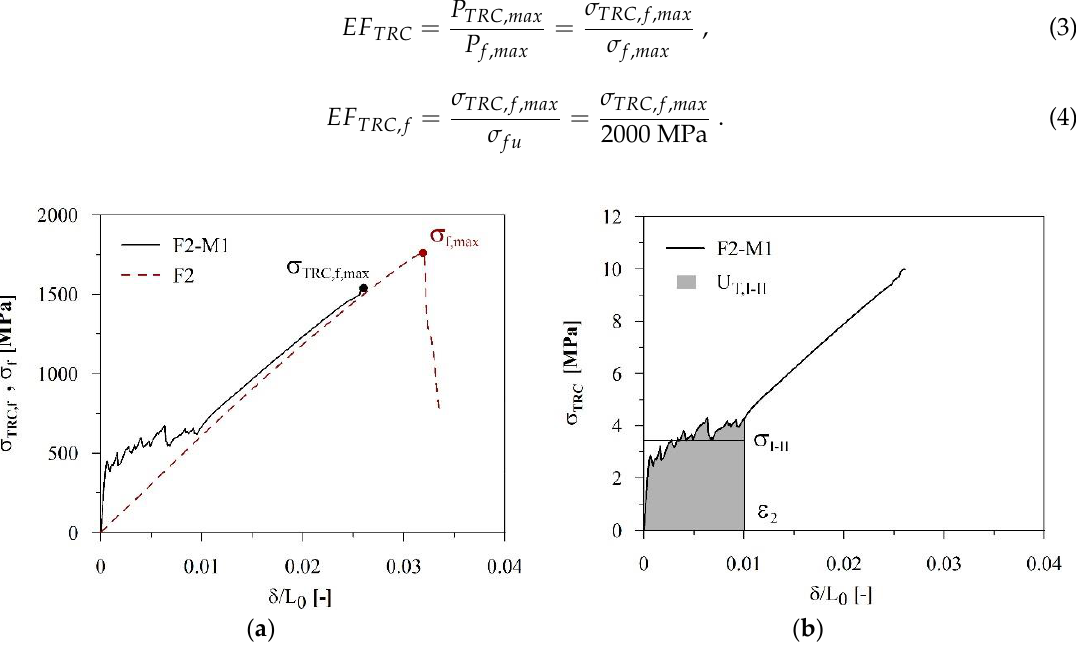
Figure 11. Identification of relevant mechanical parameters on the uniaxial tensile response: efficiency ( a ) and ductility/energy absorption ( b ) variables.